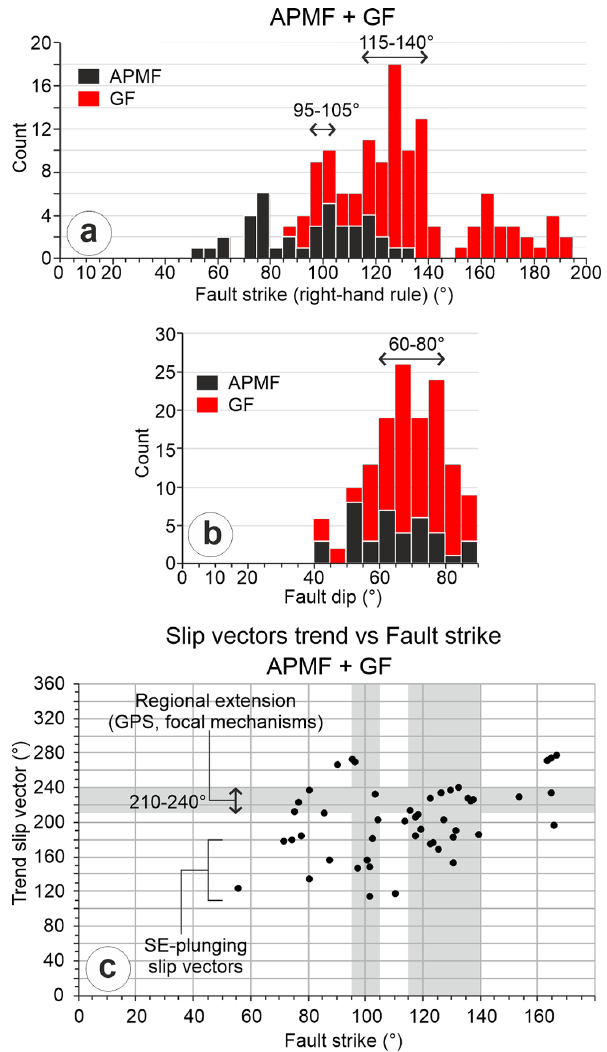
Figure 12. Summary of structural data for fault strike (a) , fault dip (b) , and slip vector trend (c) collected along the southern Matese fault system in this work (GF) and in Boncio et al. 2016 (APMF). Grey vertical bands in (c) correspond to the ranges of strike that are most represented in (b) . Numerical values, locations, and sources of point data are given in Table